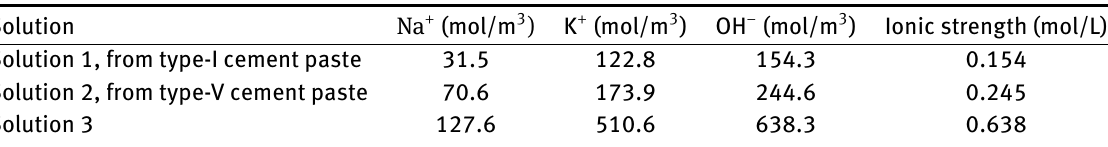
Table 2: Pore solutions